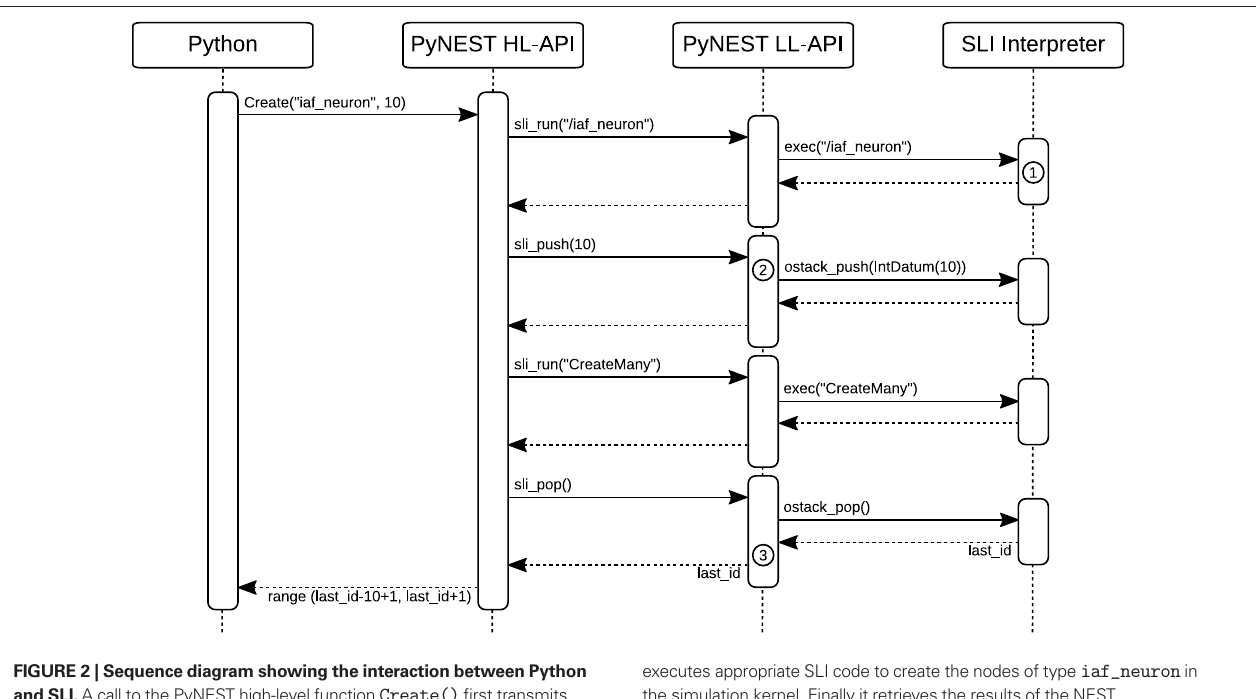
executes appropriate SLI code to create the nodes of type iaf_neuron in the simulation kernel. Finally it retrieves the results of the